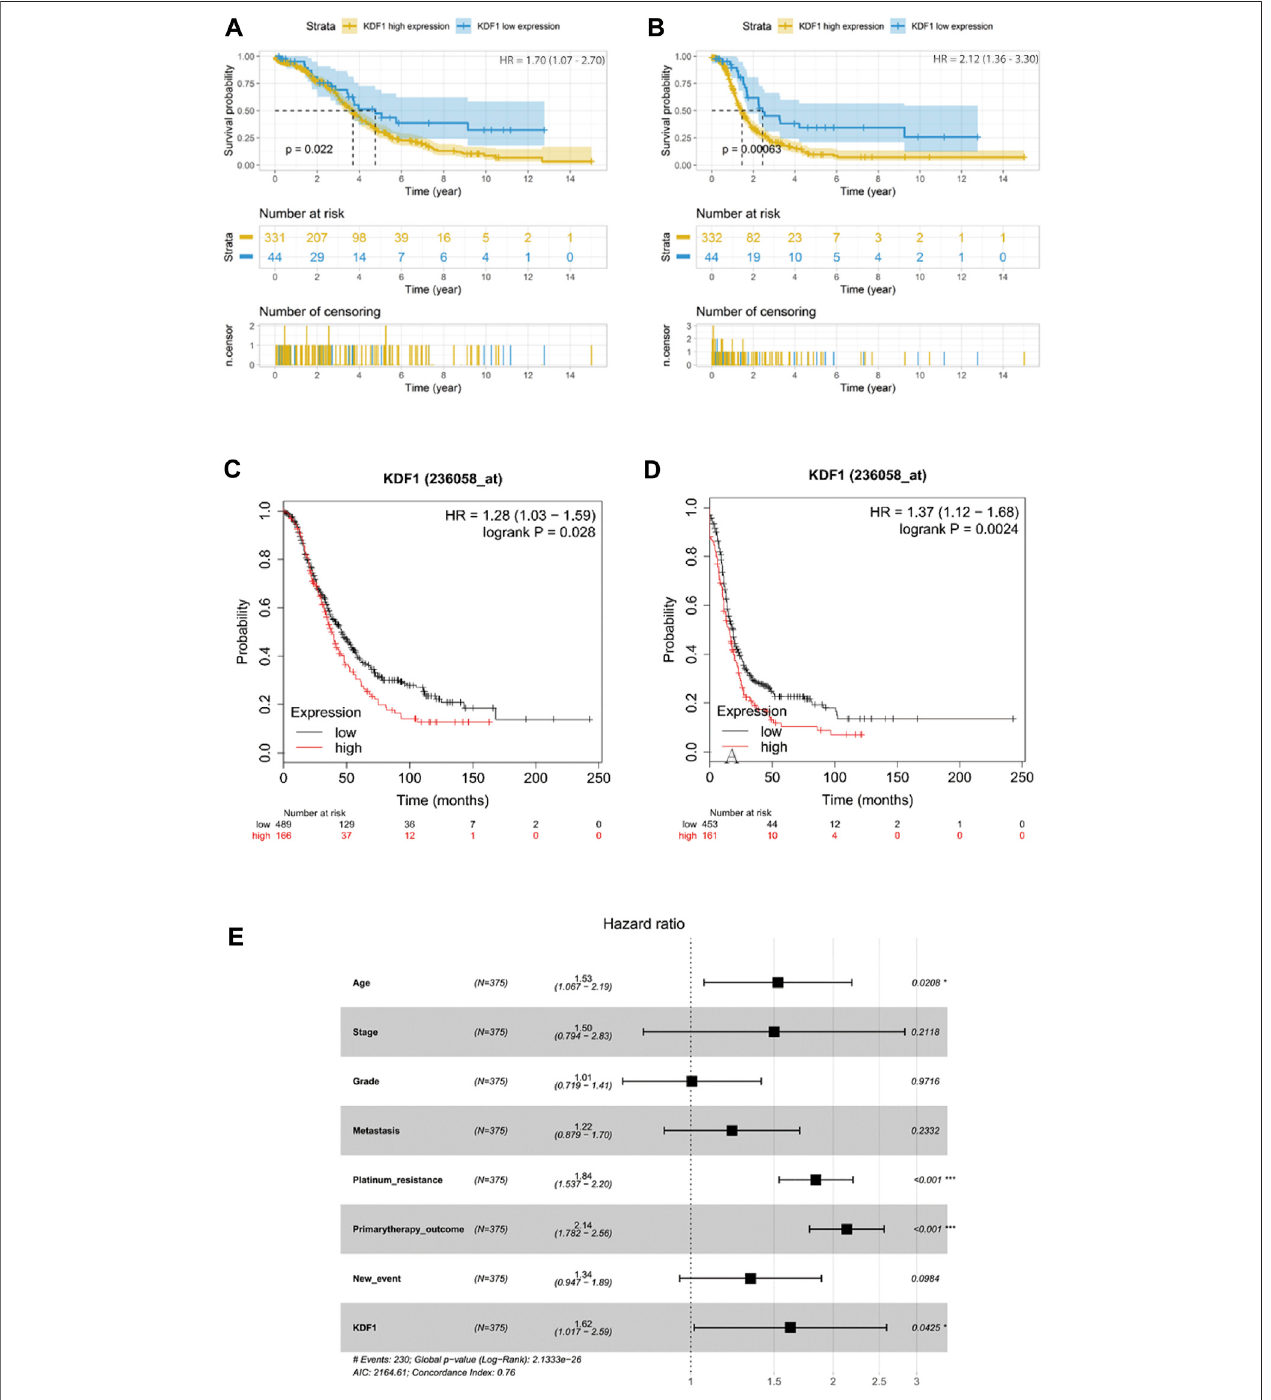
FIGURE3| PrognosticvalueofKDF1inovariancancer.HighexpressionofKDF1wasassociatedwithworseoverallsurvivalinTCGA (A) andKaplan – Meierplotter (C) .HighexpressionofKDF1wasassociatedwithworseprogression-freesurvivalinTCGA (B) andKaplan – Meierplotter (D) .ForestplotoftheprognosticvalueofKDF1 in overall survival in TCGA (E)